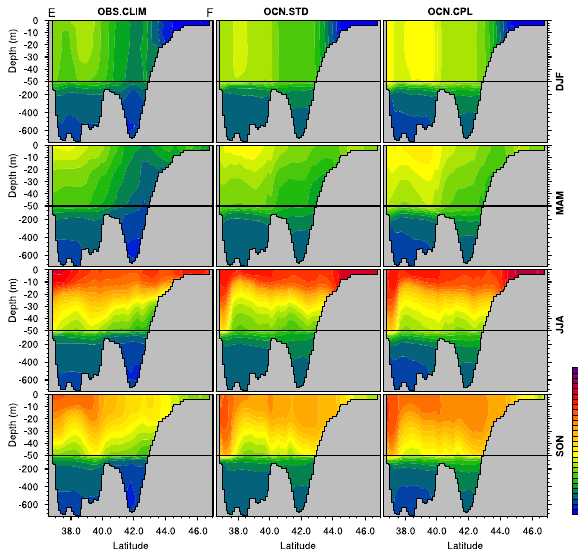
Fig. 10. Vertical cross section (E–F, see Fig. 3b) of seasonal tem- perature climatology of observation (from Ibrayev et al., 2001) and OCN.STD, OCN.CPL simulations for the period 1999–2008. Also note that the depth axis is not monotonically increasing (zoomed in to first